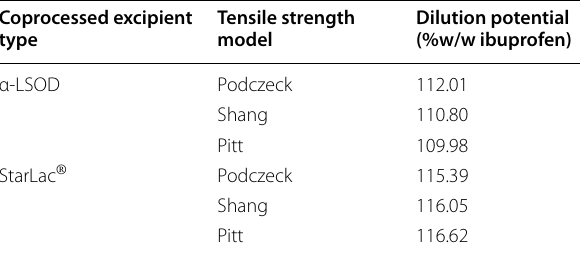
Table 4 Estimated dilution potential of coprocessed excipients based on back extrapolation using polynomial regression equations shown in Figs. 8 and 9 Coprocessed excipient